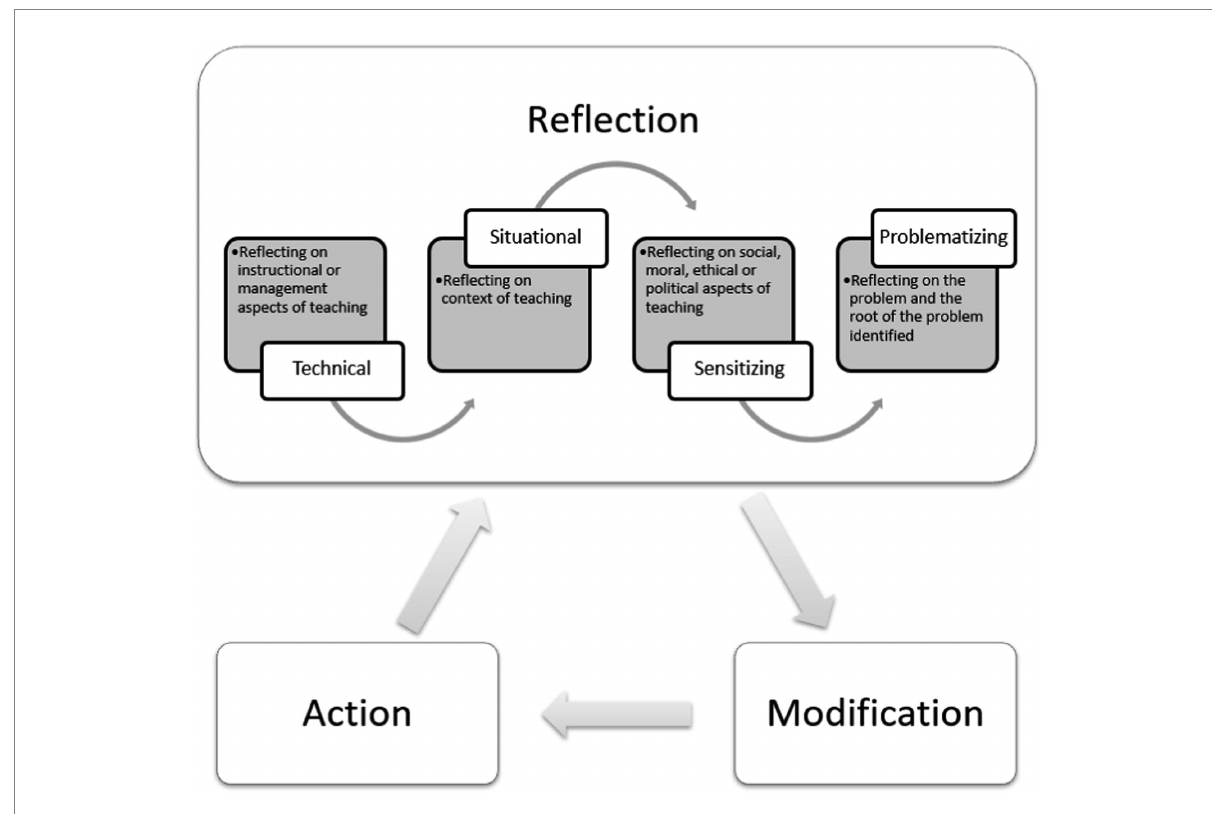
FIGURE 1 Cyclical reflective practice model capturing problem-solving, action-oriented critical